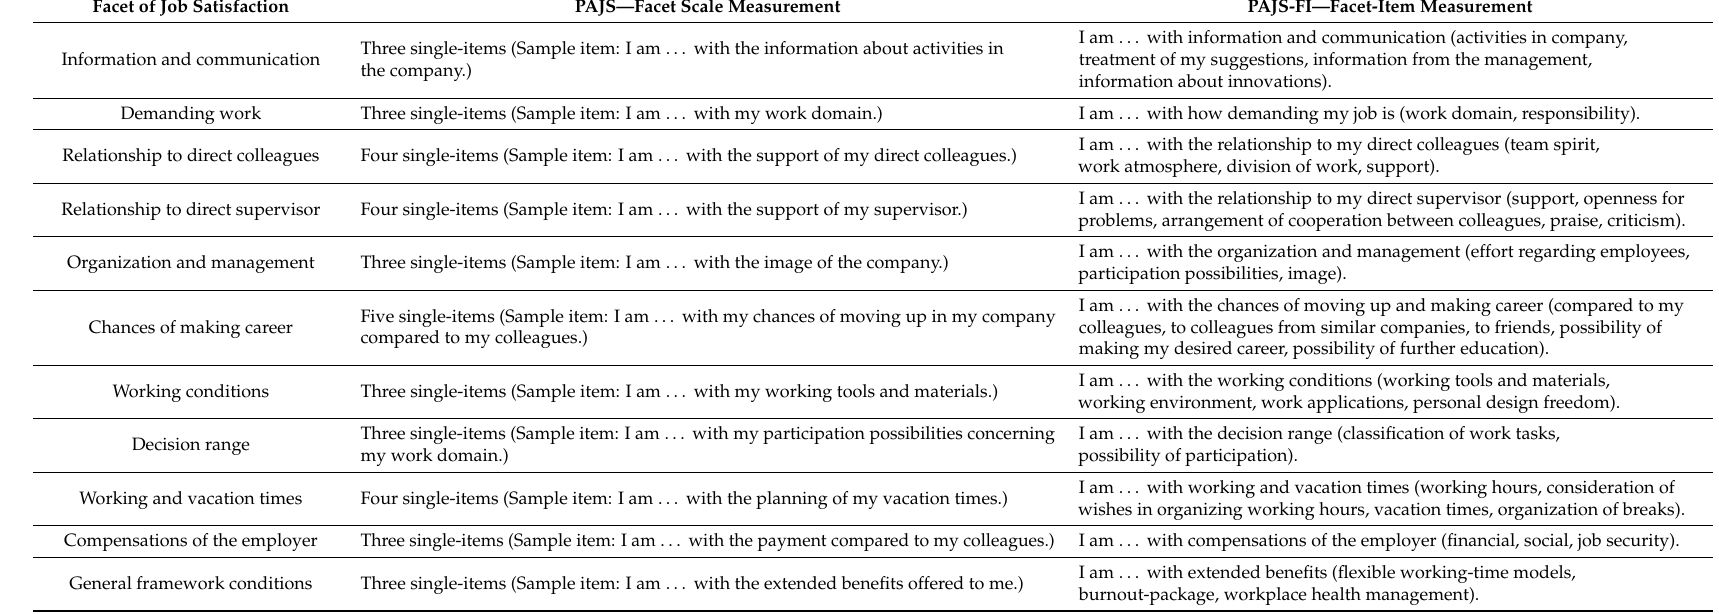
Table 2. Comparison of the Profile Analysis of Job Satisfaction (PAJS) and the PAJS-Facet-Item (PAJS-FI) 1